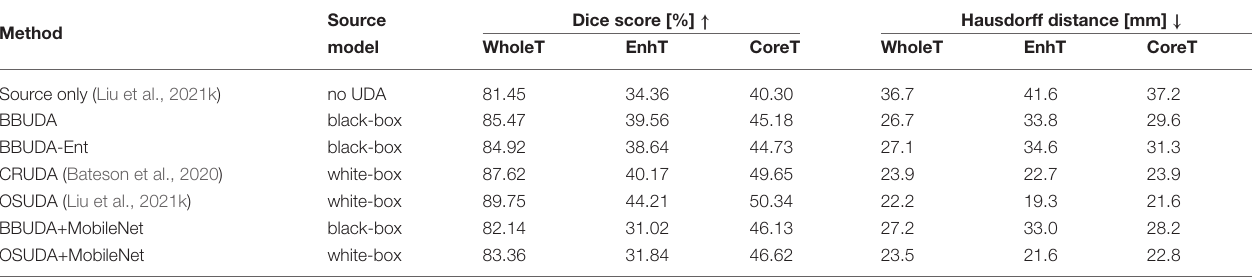
TABLE 2 | Quantitative comparisons w.r.t. DSC and HD of LGG to HGG black-box.